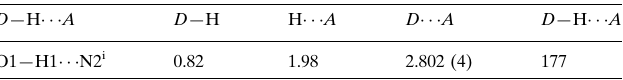
Hydrogen-bond geometry (A˚ , (cid:2)